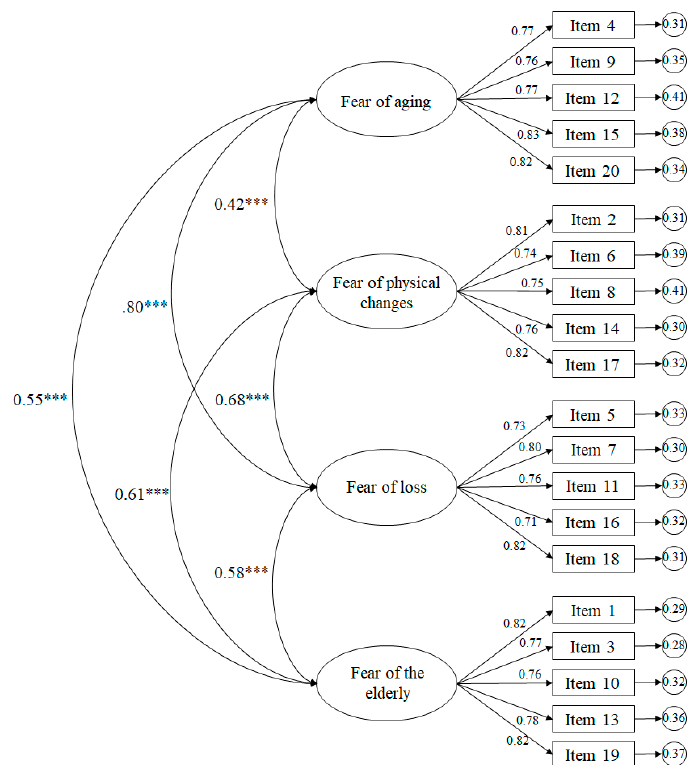
Figure 1. Confirmatory factor analysis (four factors). The ellipses represent the factors and the rectangles represent the different items. The residual variances are shown in the small circles. *** p < 0.001.